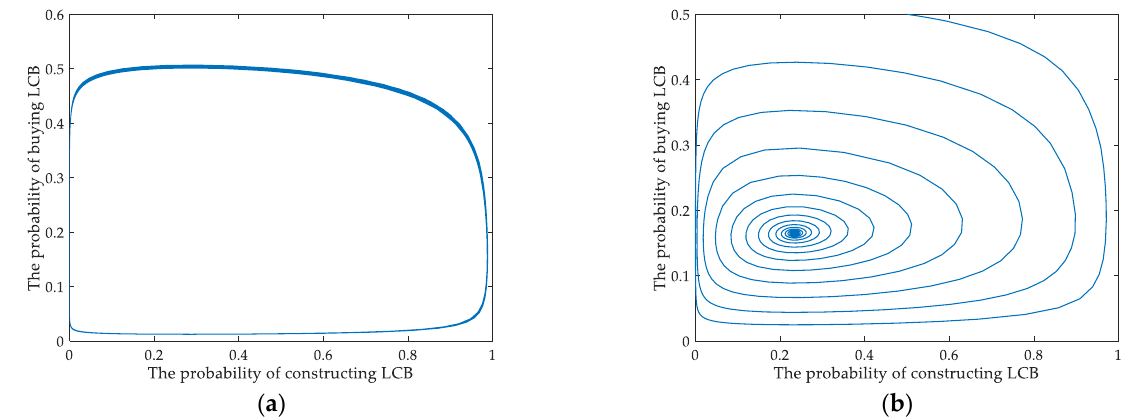
Figure 7. Evolutionary path of strategies ( a ) under static carbon tax ( b ) under dynamic carbon tax.